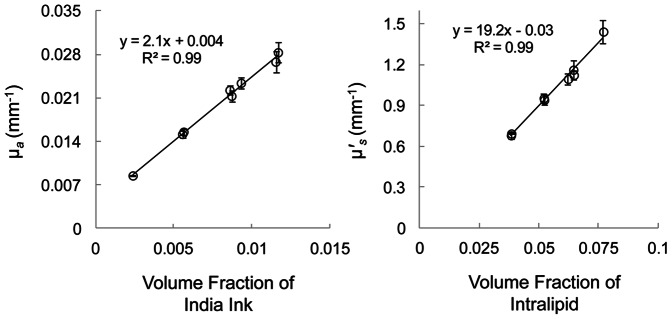
Measurement of µa (left panel) and µ′s (right panel) at 830 nm wavelength on eight homogenous phantoms in the infinite geometry, presented as a function of volume fractions of ink dilution and intralipid, respectively.The symbols and error bars represent mean and standard deviation of 20 independent measurements in each phantom. The slopes of the linear curves were used to characterize the precise quantities used in the two-layered phantom measurements.